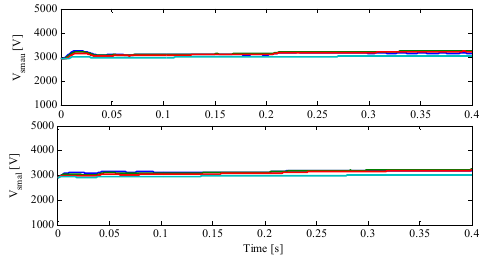
Figure 11. SM voltages of MMC with parameter variations.